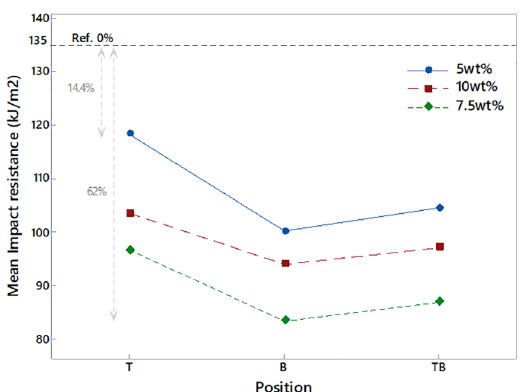
Figure 6. Interaction effect plot for mean impact